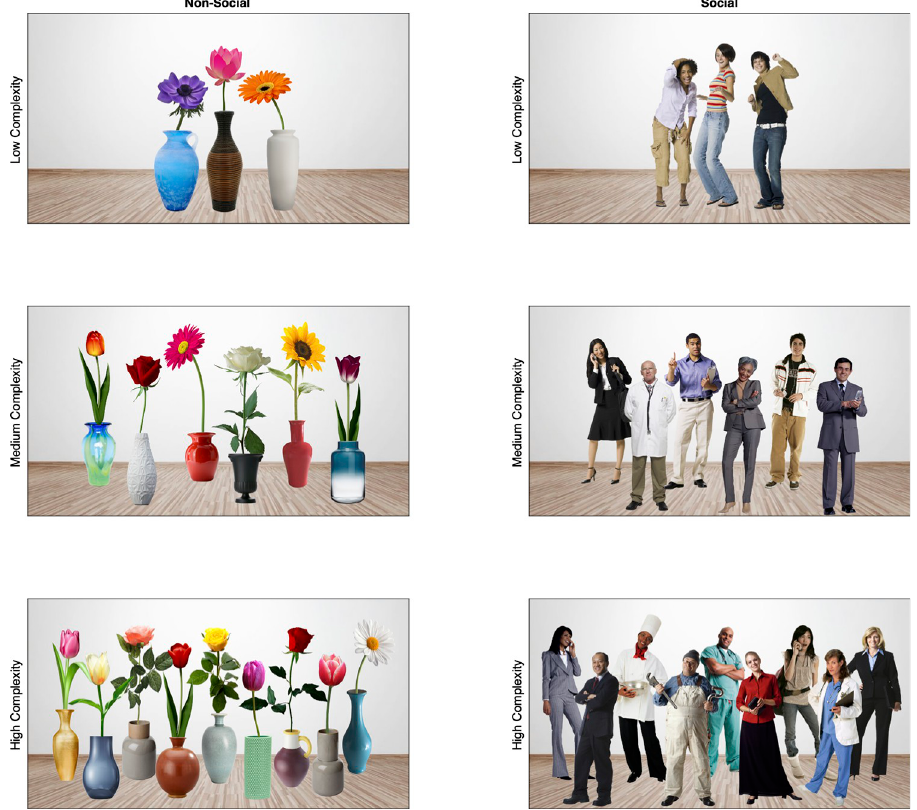
Fig 3. Quasi-naturalistic stimuli used in Experiment 2. As in Experiment 1, scenes varied by content: non-social (left column) or social (right column) and complexity: low (top row), medium (middle row) and high (bottom row). Unlike Experiment 1, trials in Experiment 2 were randomly presented for 10 seconds each and the approximate spatial location of focal points (faces or flowers) was matched across scenes for each level of complexity.